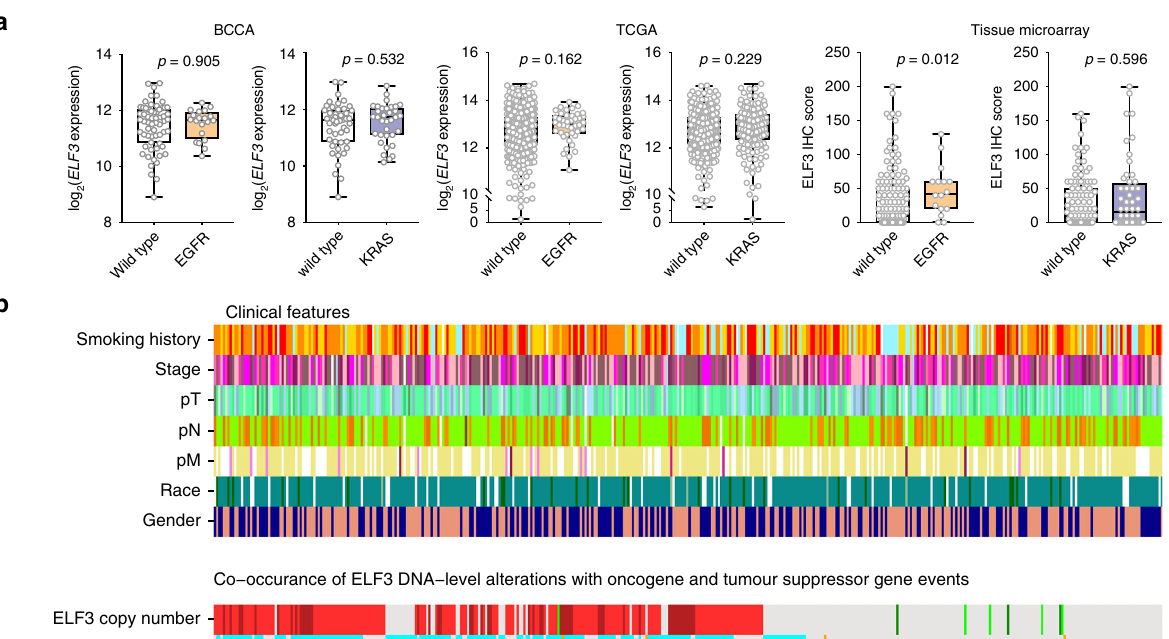
Co−occurance of ELF3 DNA−level alterations with oncogene and tumour suppressor gene events methylationELF3 copy number mutationELF3 alterationELF3 NF1STK11KEAP1TP53HRASNRASMAP2K1ERBB2METRIT1BRAFEGFRKRASELF3 DNA−level